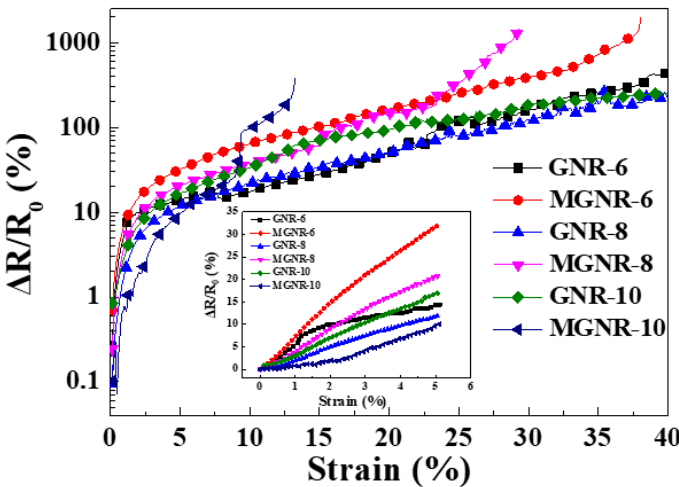
Figure 11. Relative resistance change ( Δ R/R 0 ) as a function of tensile strain in different composites.